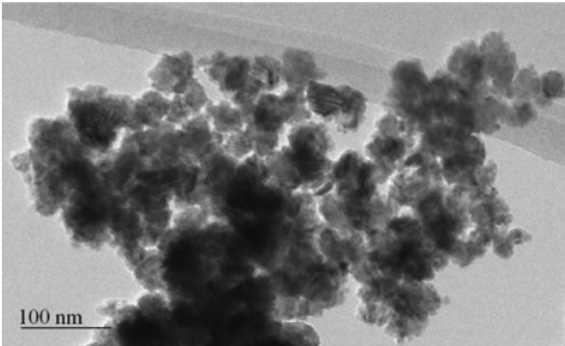
Ni alloy particles obtained in 1− x x